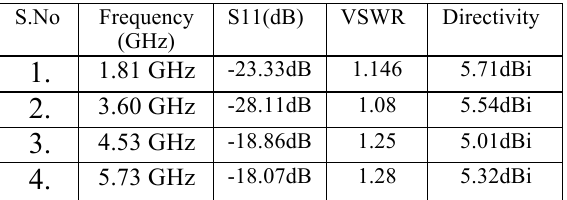
Table 2. Return loss, VSWR and directivity of different